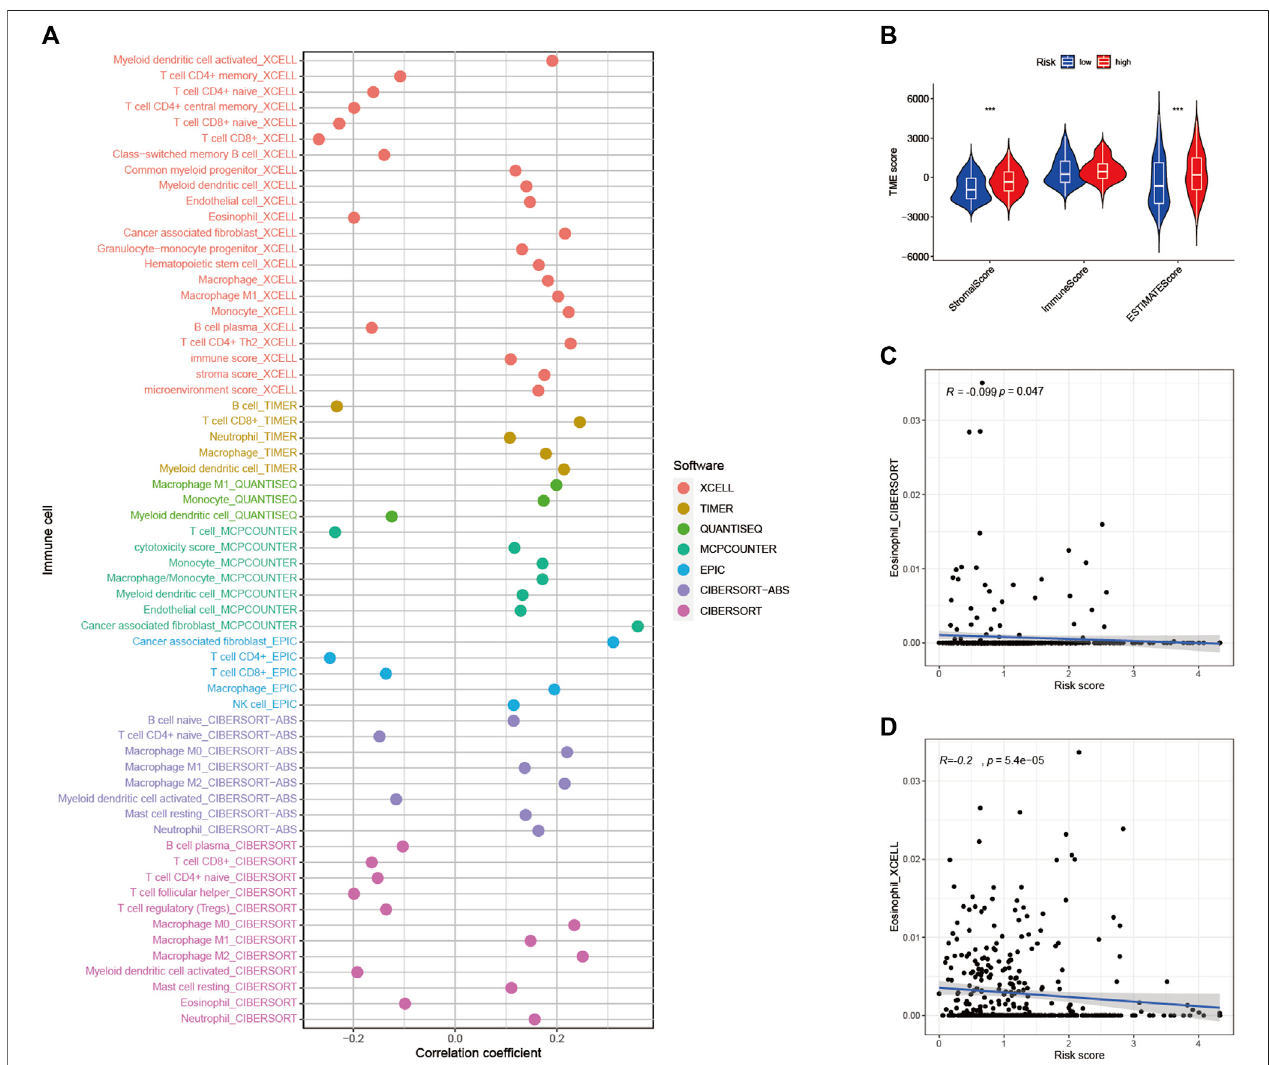
FIGURE 9 | Estimated abundance of tumor-in fi ltrating cells. Patients in the (A) high-risk group had a stronger correlation with tumor-in fi ltrating immune cells, as shown by the Spearman correlation analysis (B) Association between prognostic risk signatures and central immune checkpoint genes. The correlations predicted by the two methods CIBERSORT (C) and XCELL (D) were